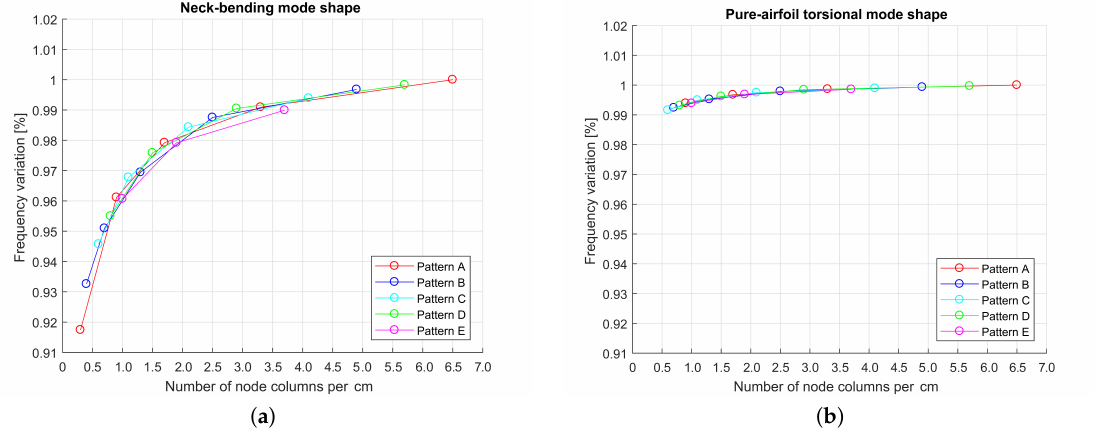
Figure 12. Variation of natural frequency versus the number of retained contact nodes. ( a ) Neck-bending mode (reference frequency = 1320 Hz). ( b ) Airfoil torsional mode (reference frequency = 1372